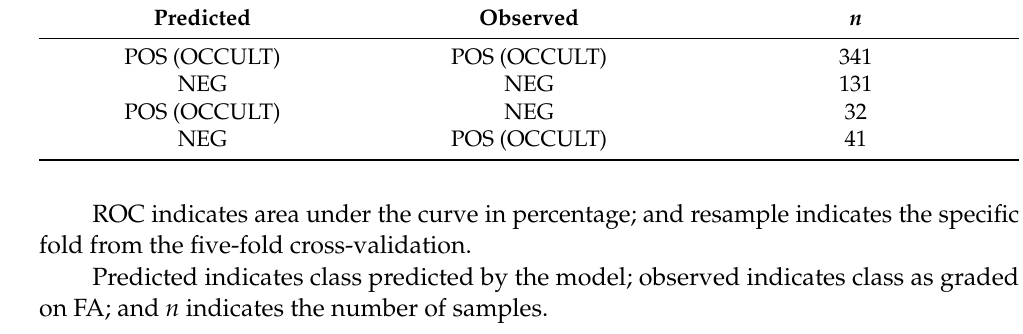
Table 5. Contingency table, counting all combinations of the predicted versus observed. Predicted